Question: Write a descriptive caption for this figure.
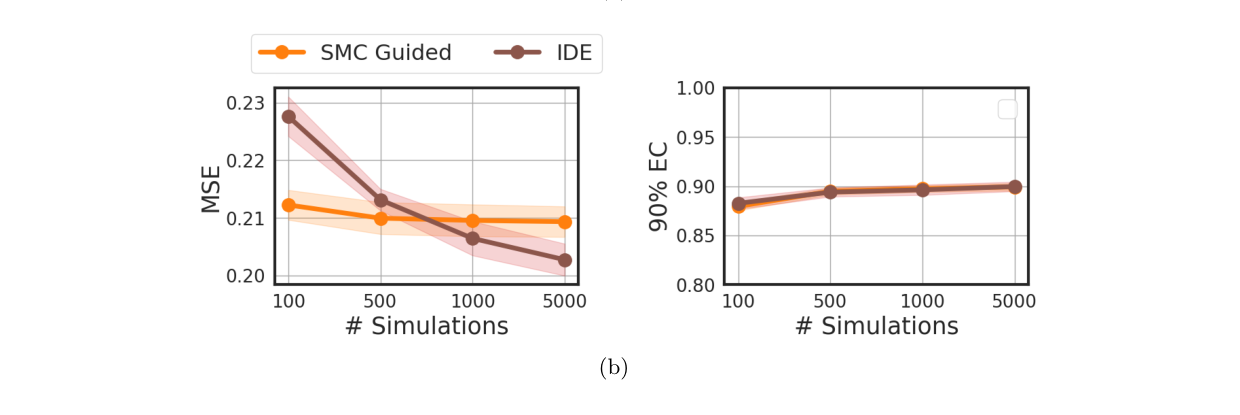
Answer: The process of using neural density estimators to approximate the joint posterior distribution p(θ, x|y) of a HMM. First, the HMM (simulator) is used to generate a training dataset {θn, xn, yn}N n=1 (A), which is then used to train three neural density estimators (B). Training of the estimators of θ happens sequentially through multiple rounds, generating more simulated data in the process. Once trained, given an observed time series yo, for each posterior sample of θ drawn using its estimator, the approximate factor recursively generates (C) importance samples of the latent path. The hidden states are resampled from these importance samples using weights that are the ratio of the true and approximate factors (see Algorithm 1 for the pseudocode).